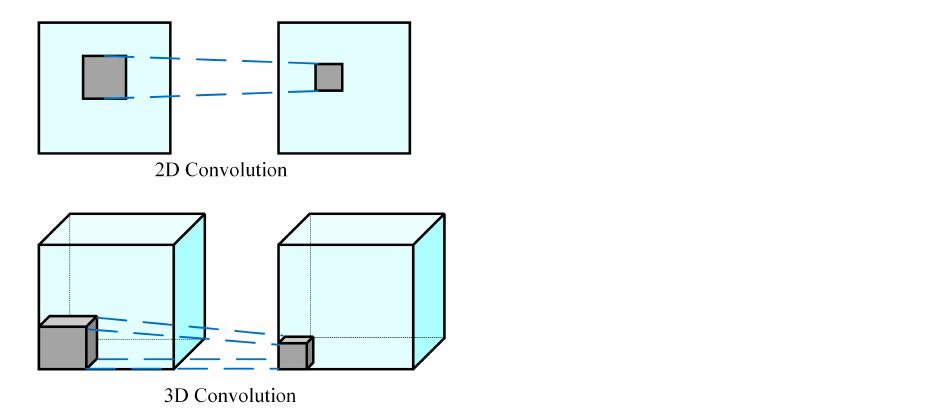
Figure 1. Comparison of the mathematical operation of 2D convolution and 3D convolution [16].